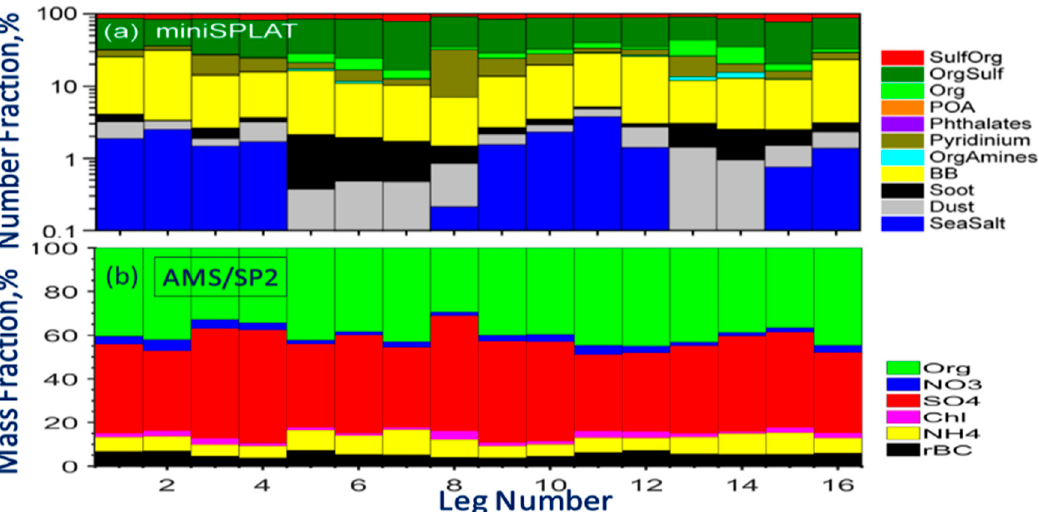
Figure 3. ( a ) Example of the FL-dependent number fraction of particles with different compositions (note the log scale) characterized by the miniSPLAT during 25 February 2013. Different types of particles are represented by different colors indicated in the legend. The length of each color bar represents the number fraction. The log scale is used to illustrate small (<3%) number fraction of sea salt particles characterized on ‘shallow’ FLs (altitude < 1 km). ( b ) The corresponding mass fraction of different chemical components (note the linear scale) characterized by the AMS and SP2.